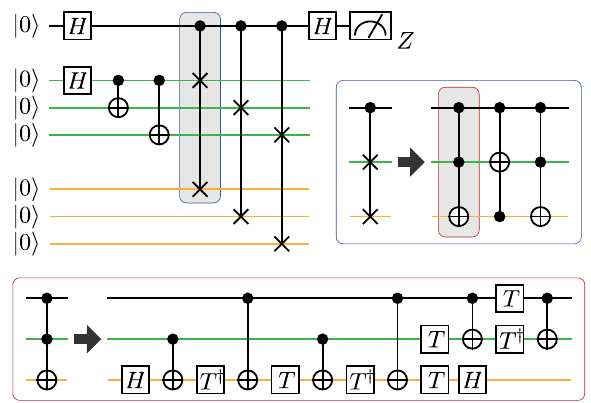
FIG. 4. SWAP -test circuit. The first qubit (denoted black) is a probe qubit, and the expected value of Z gives the overlap between states of two groups of qubits (denoted green and orange, respectively). Green qubits are prepared in the Green- berger-Horne-Zeilinger (GHZ) state ðj 00 (cid:3) (cid:3) (cid:3)i þ j 11 (cid:3) (cid:3) (cid:3)iÞ = and orange qubits are prepared in j 00 (cid:3) (cid:3) (cid:3)i . Therefore, the ideal expected value of Z is